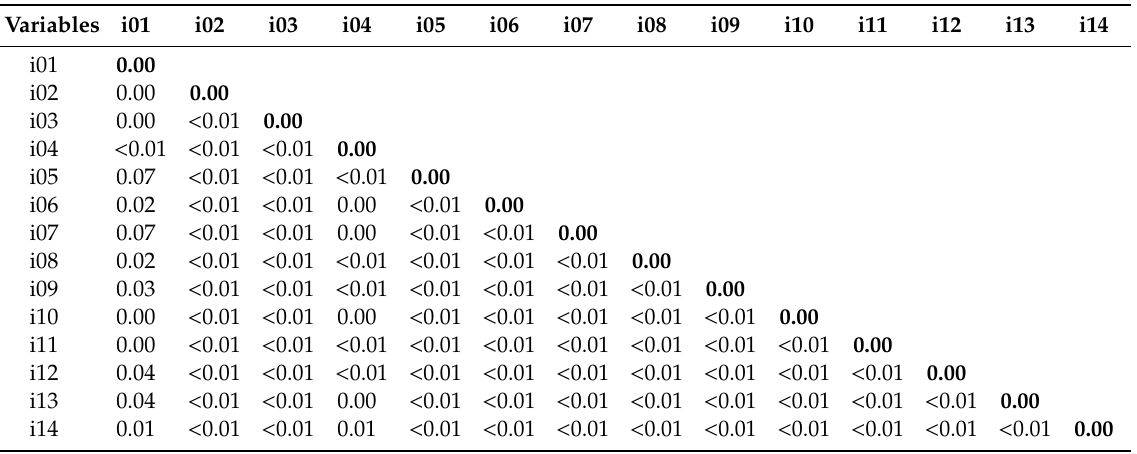
Table 8. P -values of the Pearson correlation